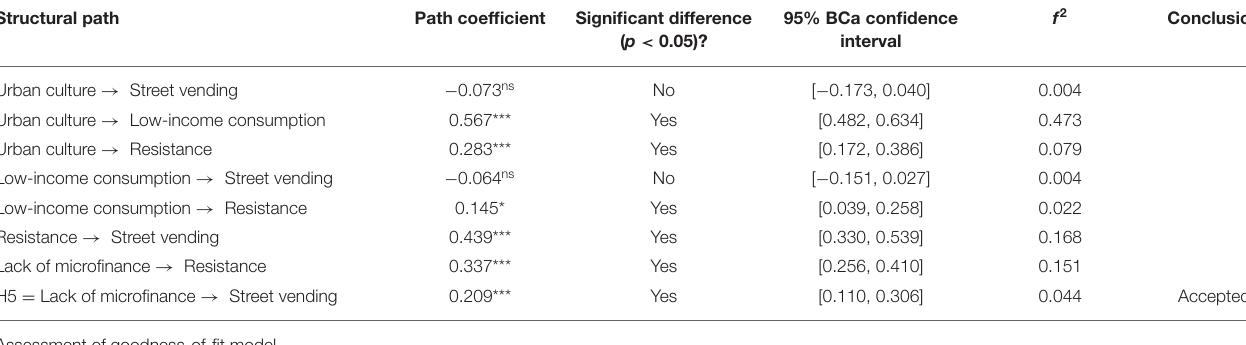
TABLE 5 | Construct effects on endogenous variables.